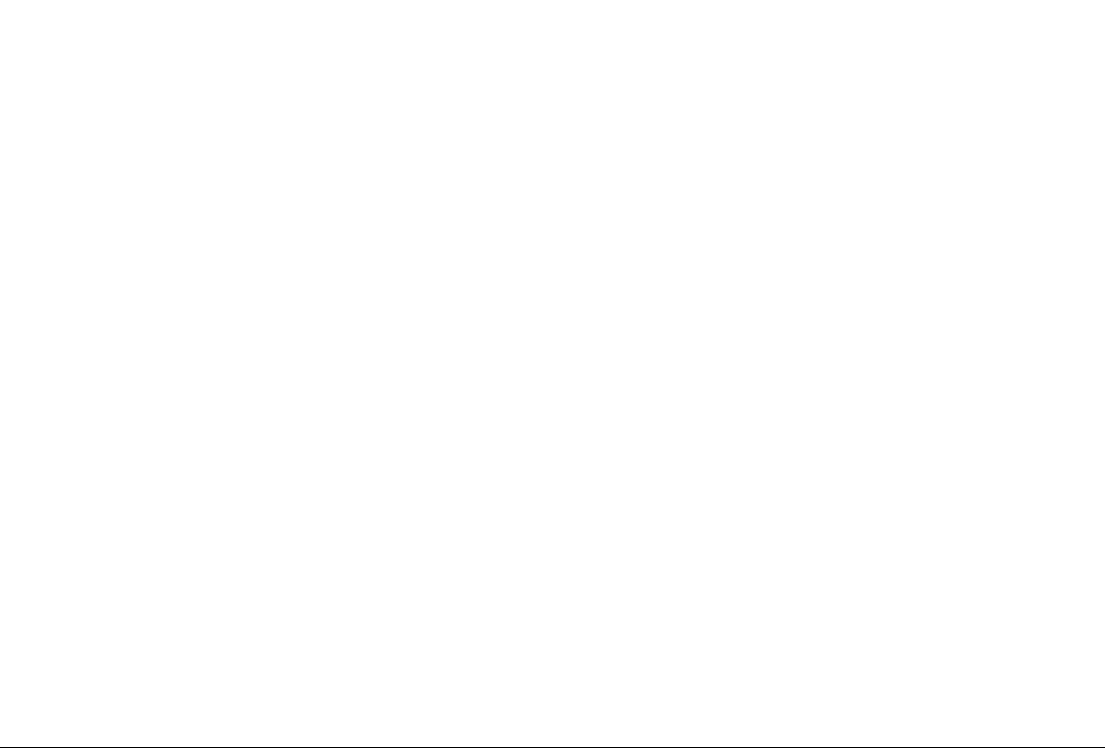
Figure 6. Local Nu number at different Da, Ri and A parameters for Case